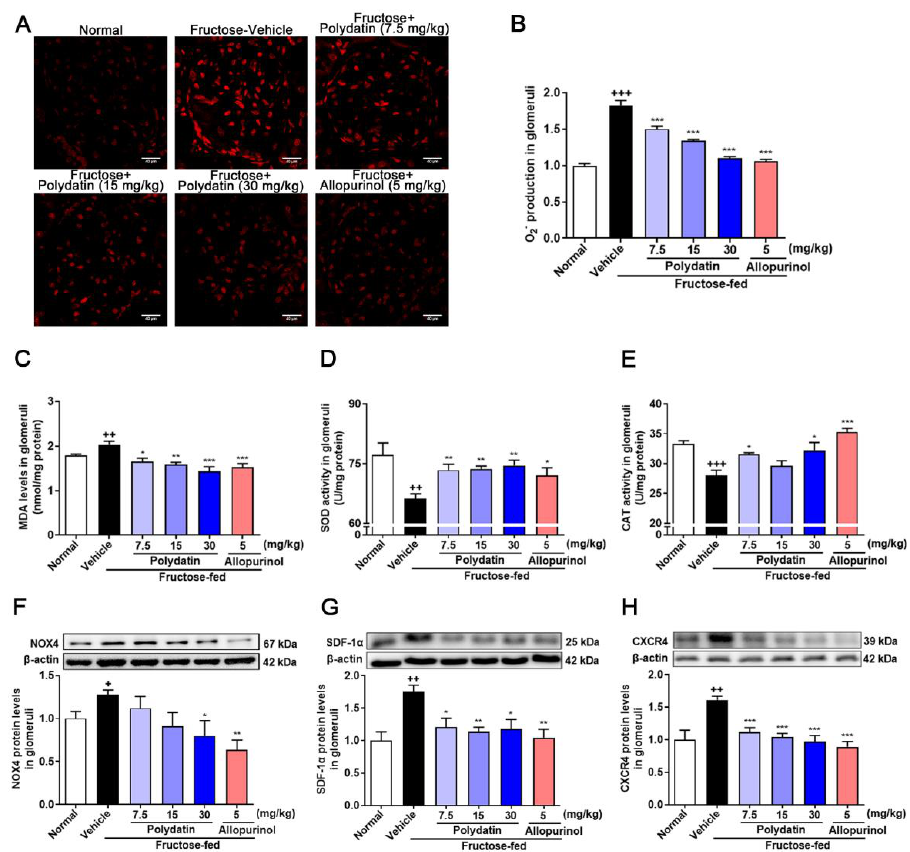
Figure 5. Polydatin prevents oxidative stress of glomeruli in high fructose-fed rats. Rats were fed 10% fructose water (wt/vol) for 13 weeks and treated with polydatin (7.5, 15, and 30 mg/kg) and allopurinol (5 mg/kg) for 7 weeks. ( A , B ) O 2 − levels were measured in rat glomeruli by fluorogenic probe DHE (red, scale bar = 40 µ m) ( n = 3) and photographed by a confocal laser scanning microscope. ( C – E ) MDA levels ( n = 5–8) ( C ), SOD activity ( n = 6–7) ( D ) and CAT activity ( n = 5–7) ( E ) were measured in rat glomeruli respectively. ( F – H ) Relative protein levels of NOX4 ( n = 4–6) ( F ), SDF-1 α ( n = 4–5) ( G ) and CXCR4 ( n = 4–5) ( H ) were detected in rat kidney glomeruli by Western blot and quantified by Image J. Data are expressed as the mean ± S.E.M. + p < 0.05, ++ p < 0.01, +++ p < 0.001 compared with normal control group, * p < 0.05, ** p < 0.01, *** p < 0.001 compared with fructose vehicle group.